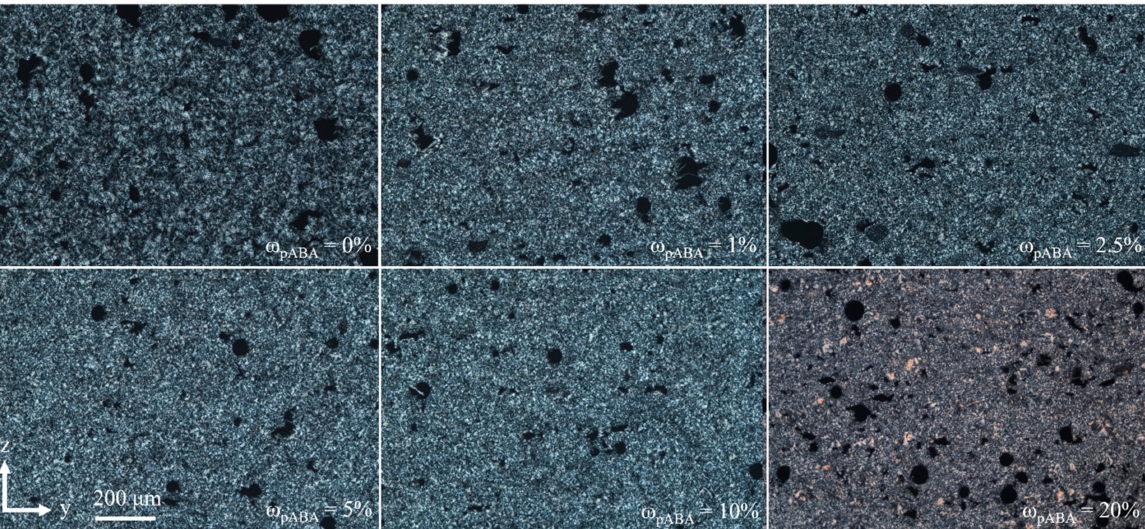
Figure 10. Polarized light micrographs of manufactured tensile specimens in dependence of the fraction of p-aminobenzoic acid.